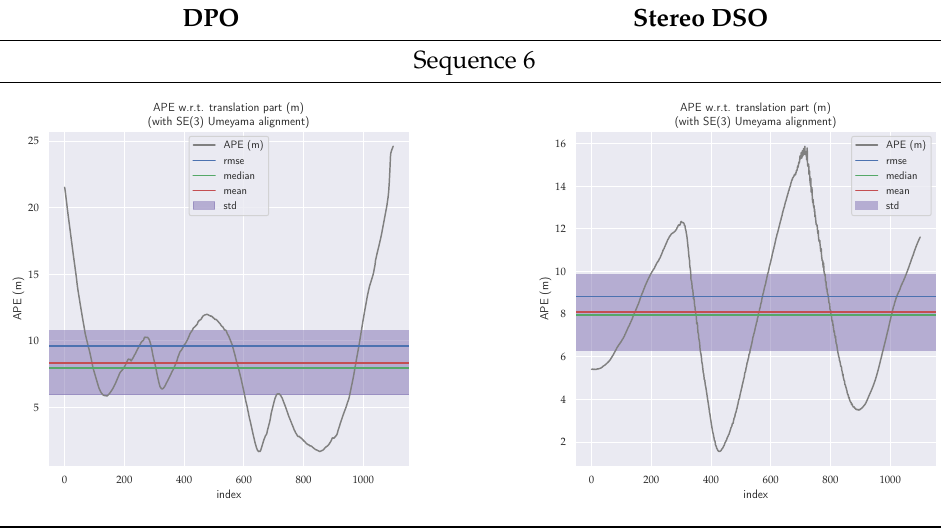
Table 2. The absolute pose error (APE) for all frames of sequences 6 and 7 of the KITTI